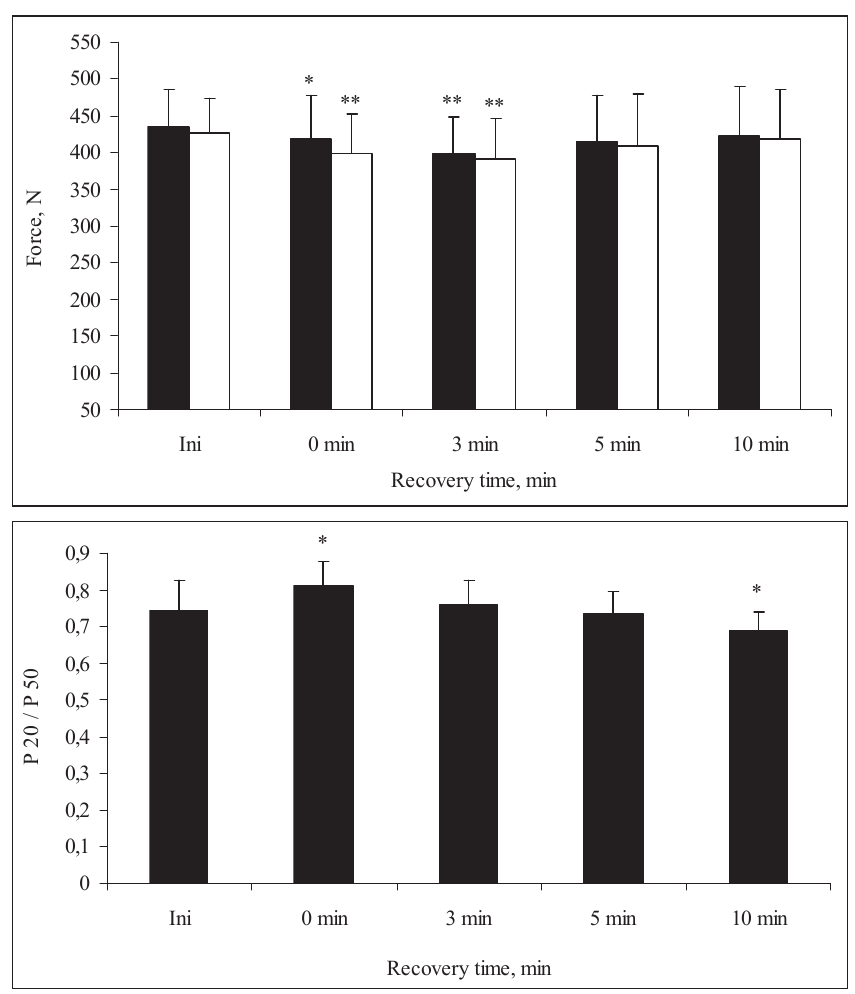
Note. P 20 and P 50, muscle con- traction force at a stimulation rate of 20 Hz and 50 Hz respectively; Va- lues are means ± SD. Statistically significant differences from initial mean level (Ini) are indicated as: * — p < 0.05 (n =